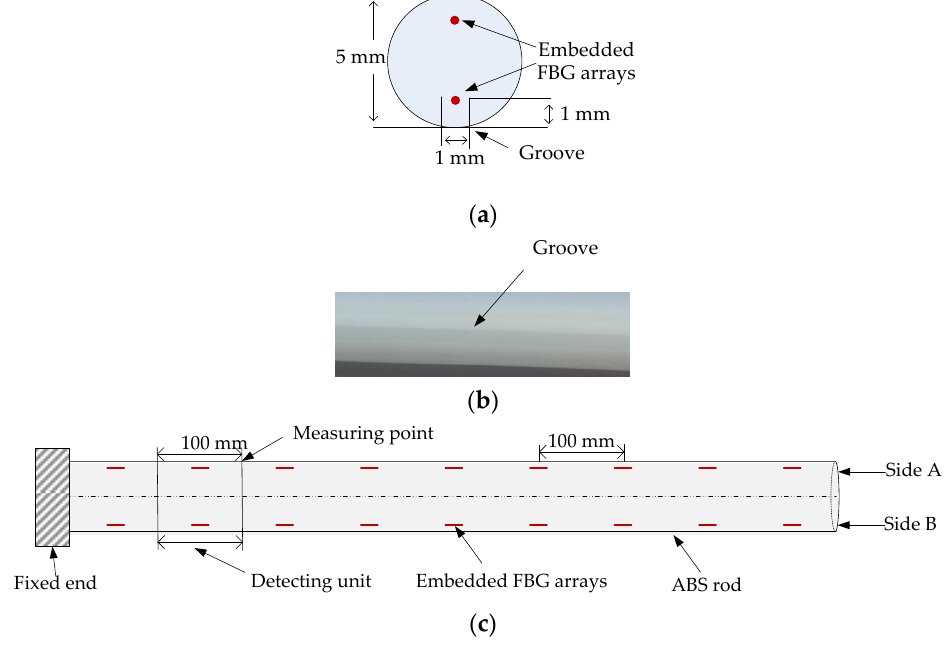
Figure 1. Schematic diagram of the proposed FBG implantable flexible morphological sensor. ( a ) Side view of sensor. ( b ) A groove on the surface of a flexible rod. ( c ) Positive view of the sensor. Table 1. The detailed parameters of fiber Bragg grating (FBG) sensing